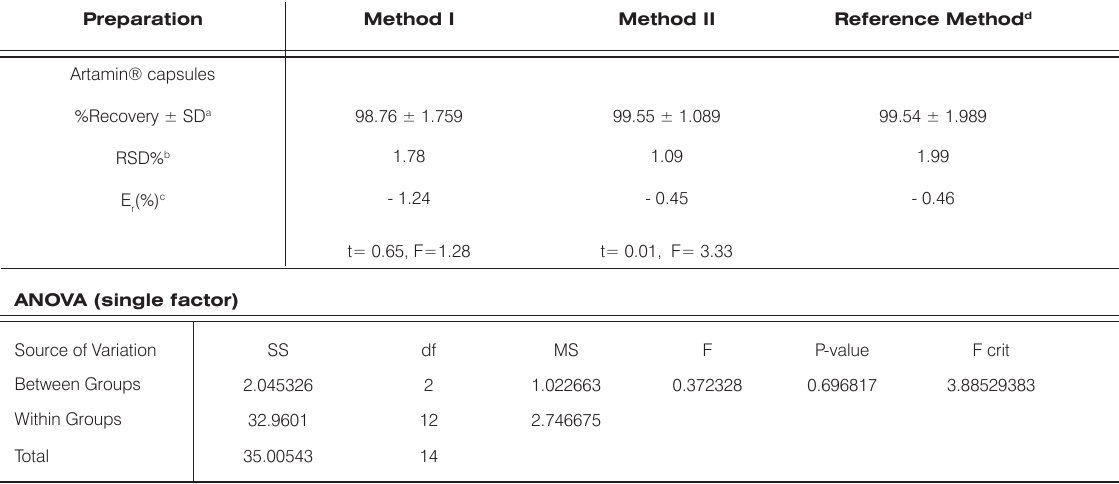
Figure 5. Effect of heating temperature and time on the redox reaction between Ce(IV) (1×10 -3 M) and 0.216 μg mL -1